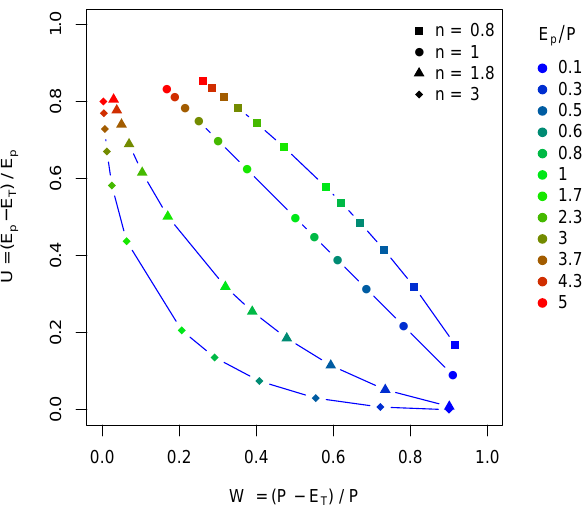
Fig. 3. Mapping of CCUW hypothesis into Budyko space for dif- ferent values of catchment efficiency ( C E ) using Eq. (26). For com- parison different parameterisations of the Mezentsev curve are also shown. The grey lines depict the theoretical limits for water and